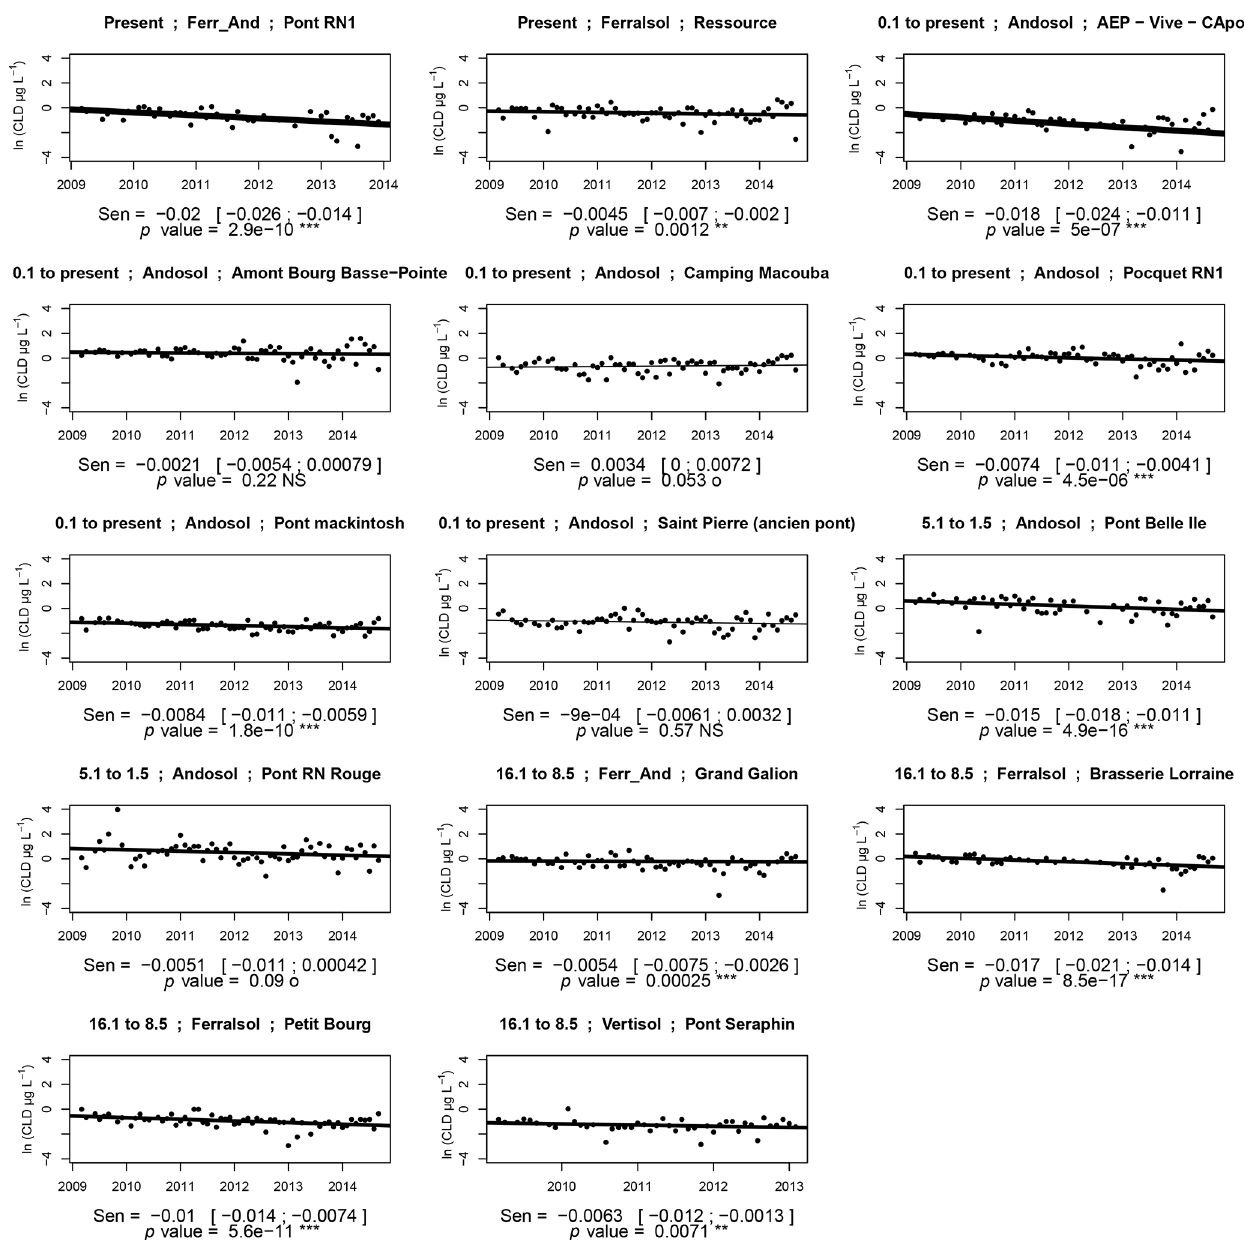
Figure 6. CLD (natural logarithm) trends in SW according to geology and soil type. Sen trend and confidence interval; p value of the modified Mann–Kendall test for serially correlated data using the Yue and Wang variance correction approach. CLD content significantly decreased ( p value<0.05) for 10 out of 14 rivers. Thick lines (Pont RN1 and AEP-Vive-Capot) indicate a large decrease (lower than percentile 0.1 of Sen trends); thin lines (Camping Macouba and Saint Pierre) indicate a small decrease (higher than percentile